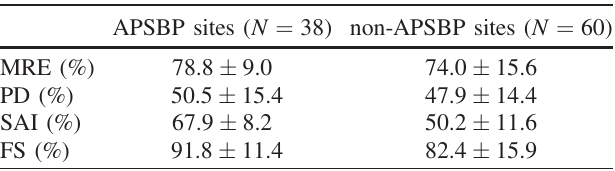
TABLE VIII. μ (cid:3) σ for the two APSBP affiliated and nonaf- filiated departments on the four ASES